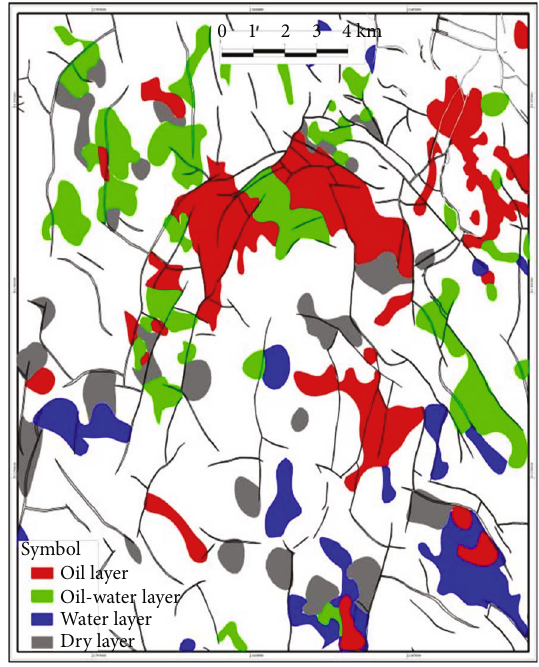
Figure 2: Upper of oil and water distribution on Portugal